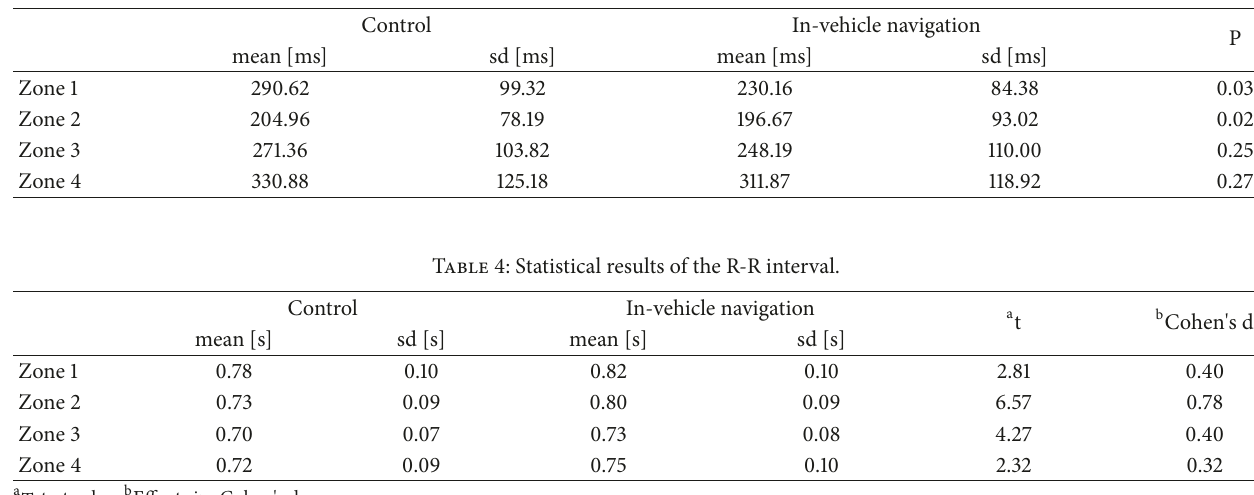
Table 3: Statistical results of the average duration of fixations.